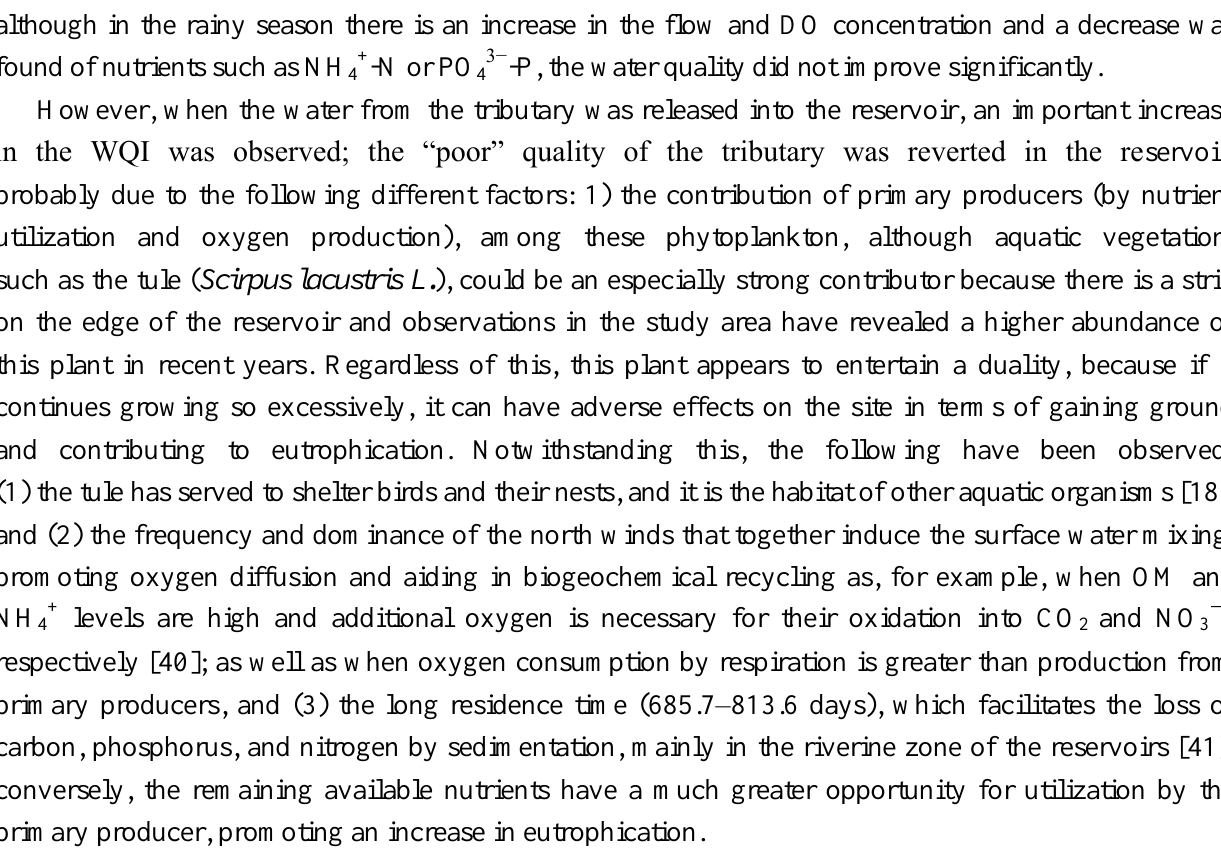
Figure 5. Water quality index (WQI) from dates of the year 2011 [42,43]. ( a ) Tributary and ( b ) Reservoir (Station